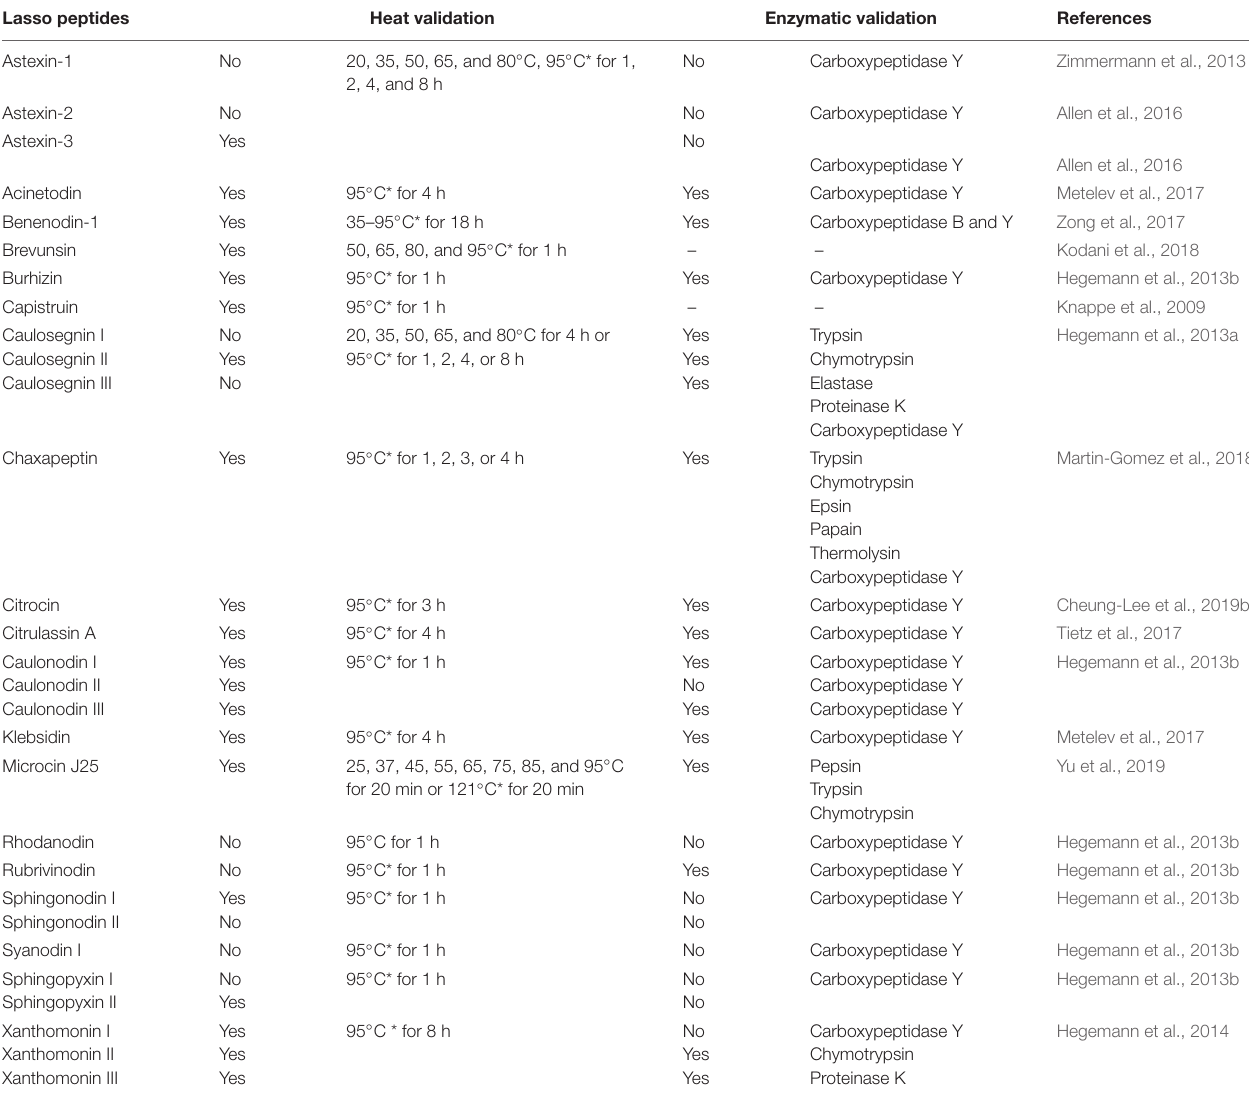
TABLE 1 | Thermal stability, enzymatic stability of commonly known lasso